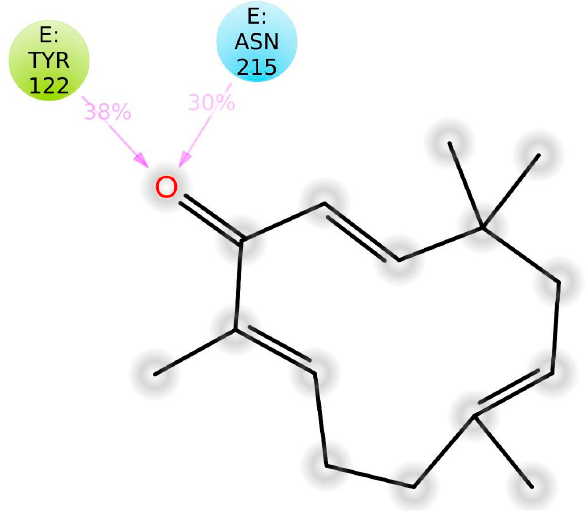
Figure 11. A representation of atomic interactions between ZER and integrin α v β 3 protein residues during 20 ns molecular dynamics simulation.